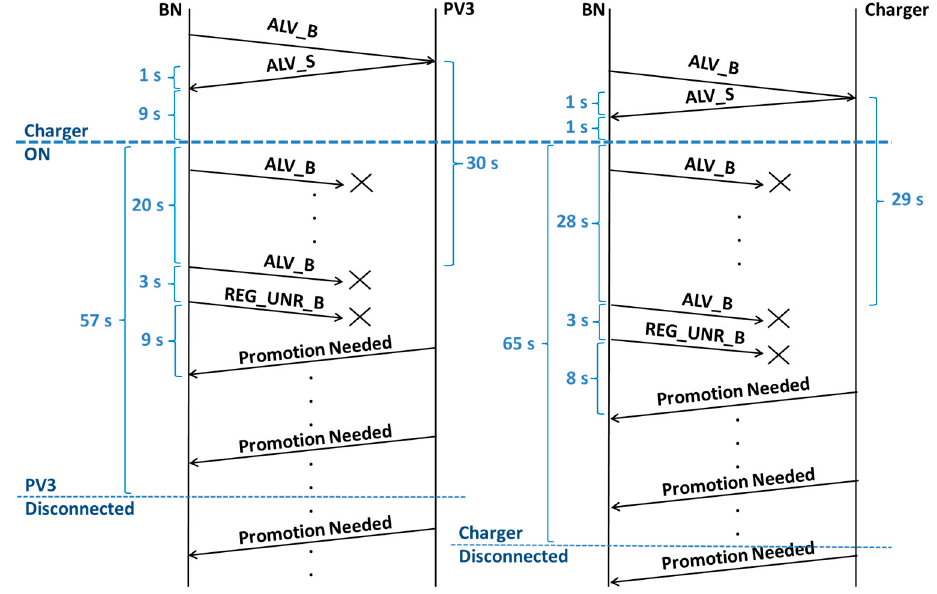
Figure 20. Sequence of MAC packets between the BN and the PV3 SN and between the BN and the Charger SN, respectively.